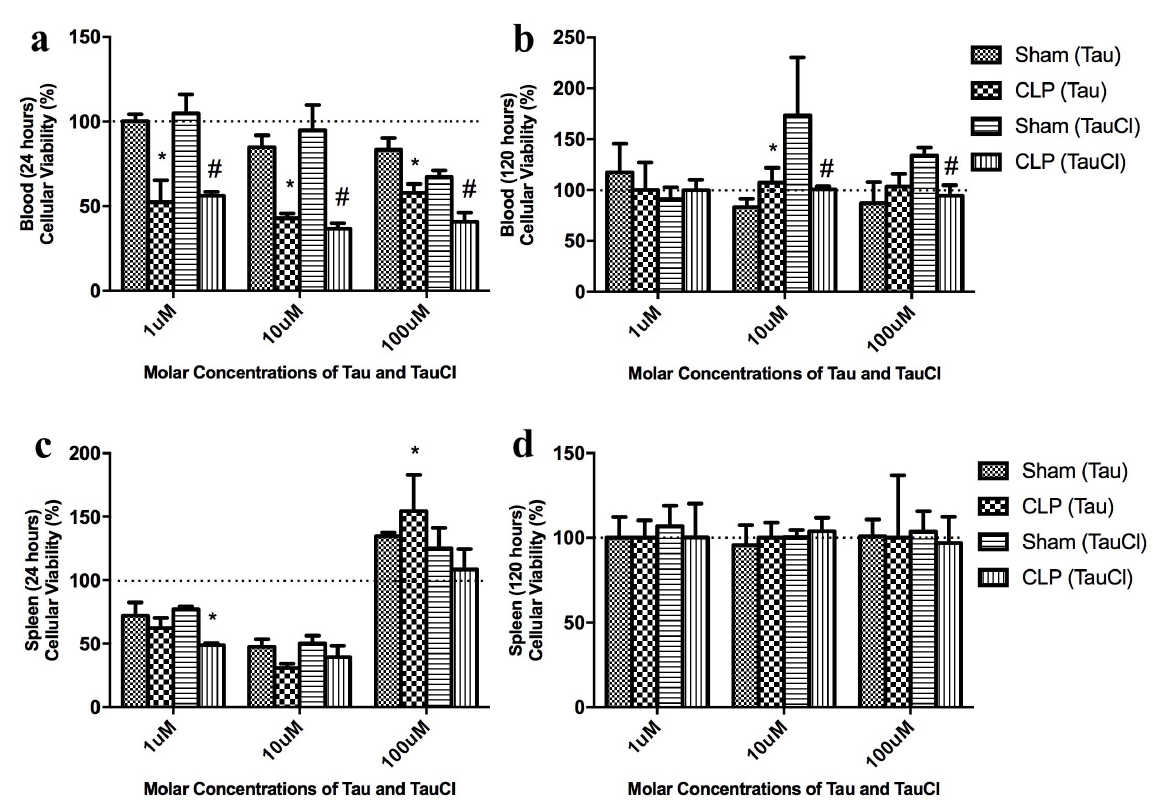
Figure 1. Cell viability measurement by MTT assay. Viability of lymphocytes treated with Tau and TauCl in different molar concentrations. Rats were submitted to CLP or Sham, and 24 or 120 hours after the surgery their blood and spleens were collected, the lymphocytes were isolated, cultured and the cell viability was measured by MTT assay. (a) blood, 24 hours; (b) blood, 120 hours; (c) spleen, 24 hours; (d) spleen, 120 hours. * = P < 0.05 for CLP compared with sham group (Tau-treated). # = P < 0.05 for CLP compared with Sham group (TauCl-treated). (n =